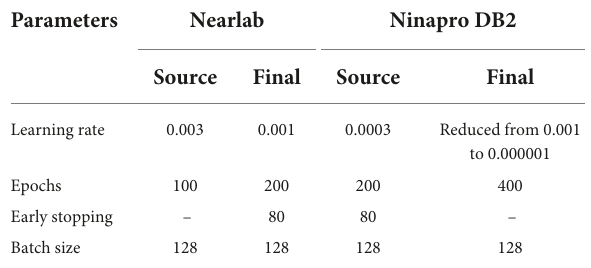
TABLE 3 Learning parameters of PFCnet for Nearlab and Ninapro DB2